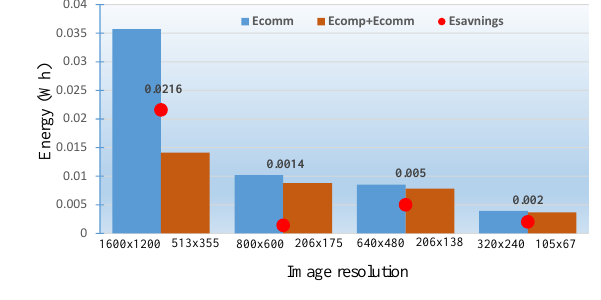
image (blue block). The red dots show the total time saved in minutes during transmission.